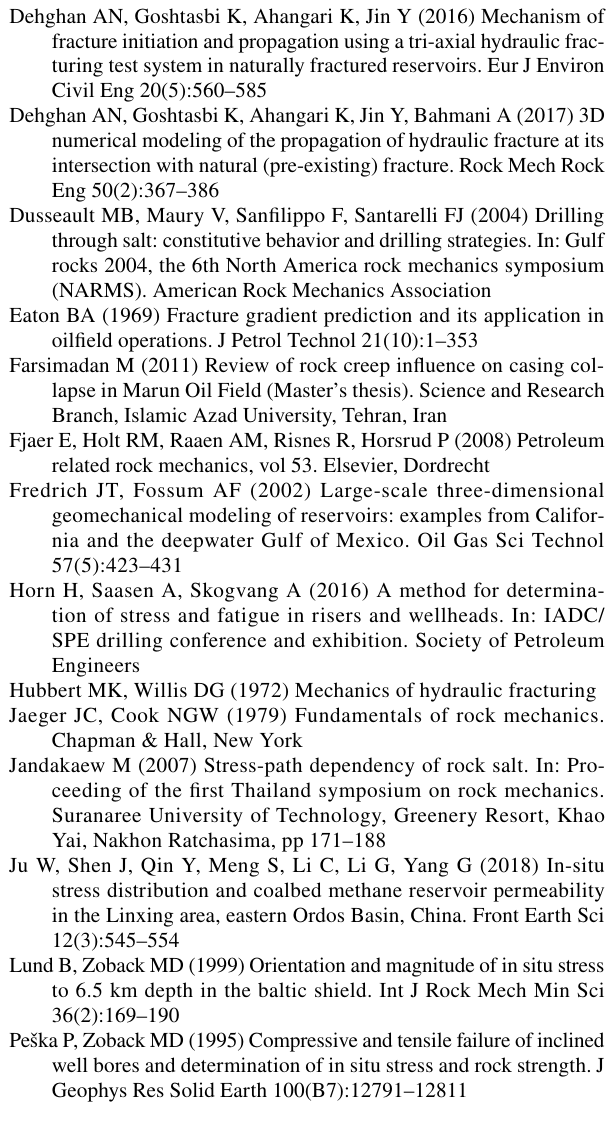
Table 1 The in situ stress results for Marun 42, 130, and 133 wells